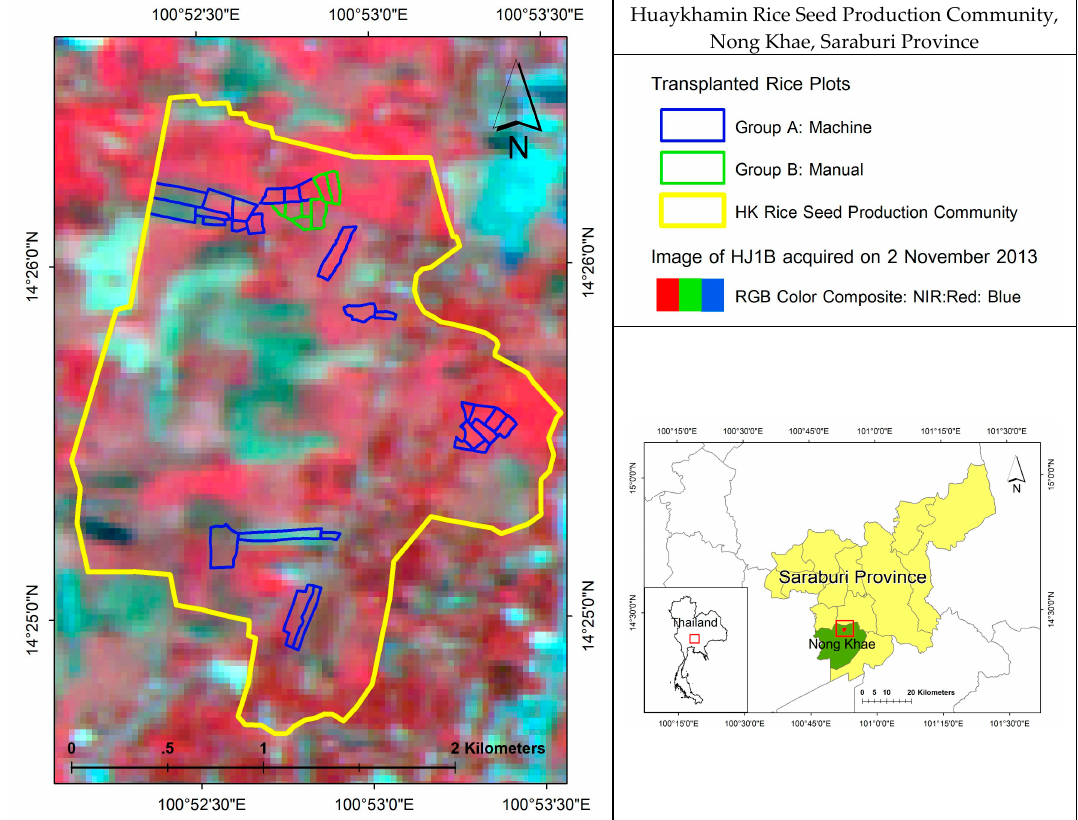
Figure 1. Location of study area and field observation sites.